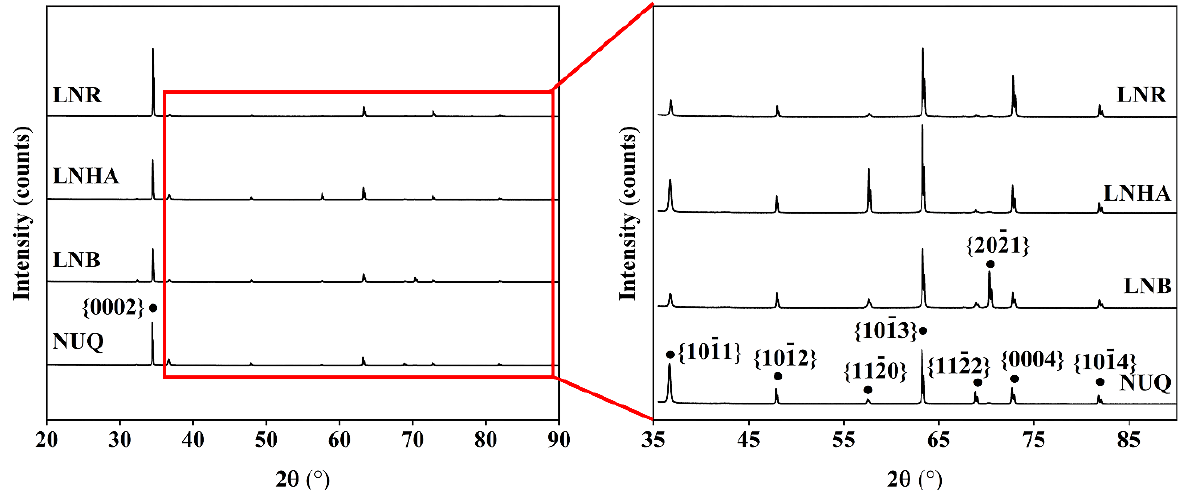
Figure 8. XRD patterns of AZ31B plates processed with different uphill quenching processes.